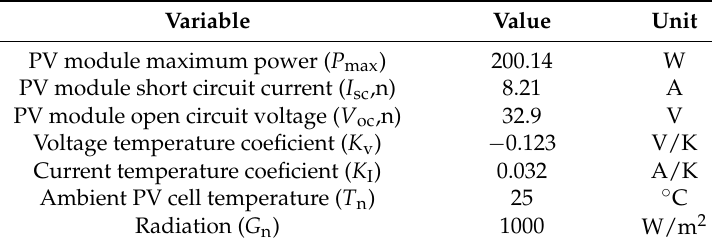
Figure 12. Simulation of interfaced photovoltaic (PV)-based DC micro-grid with power system, including a wind generator, by proposed UPQC. The wind generation supplies a 120 kV power grid through one 10 km line and a 20 kV feeder. The simulated wind power plant has six doubly fed induction generators (DFIG) which include a